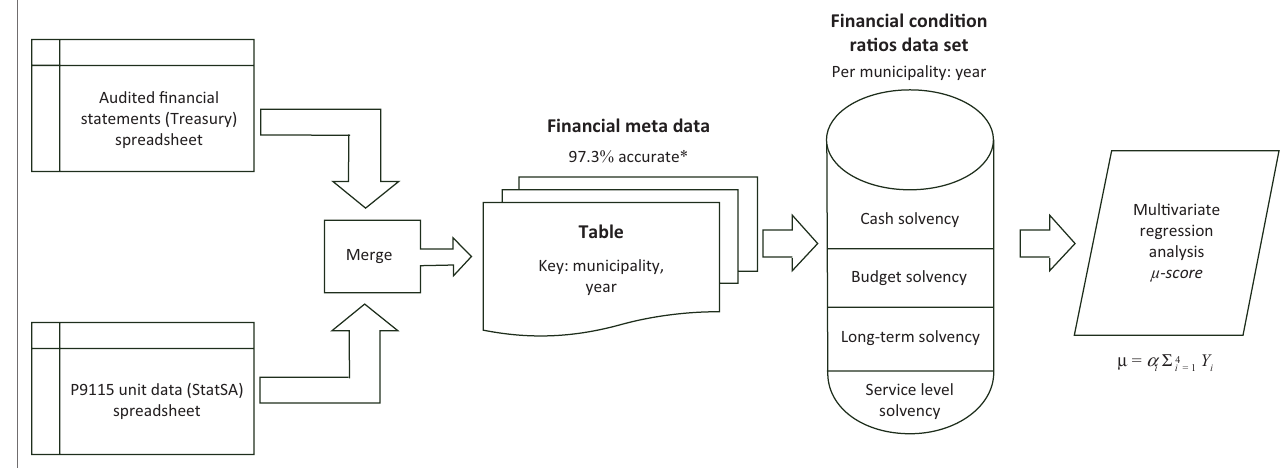
FIGURE 2: Construction of the financial condition